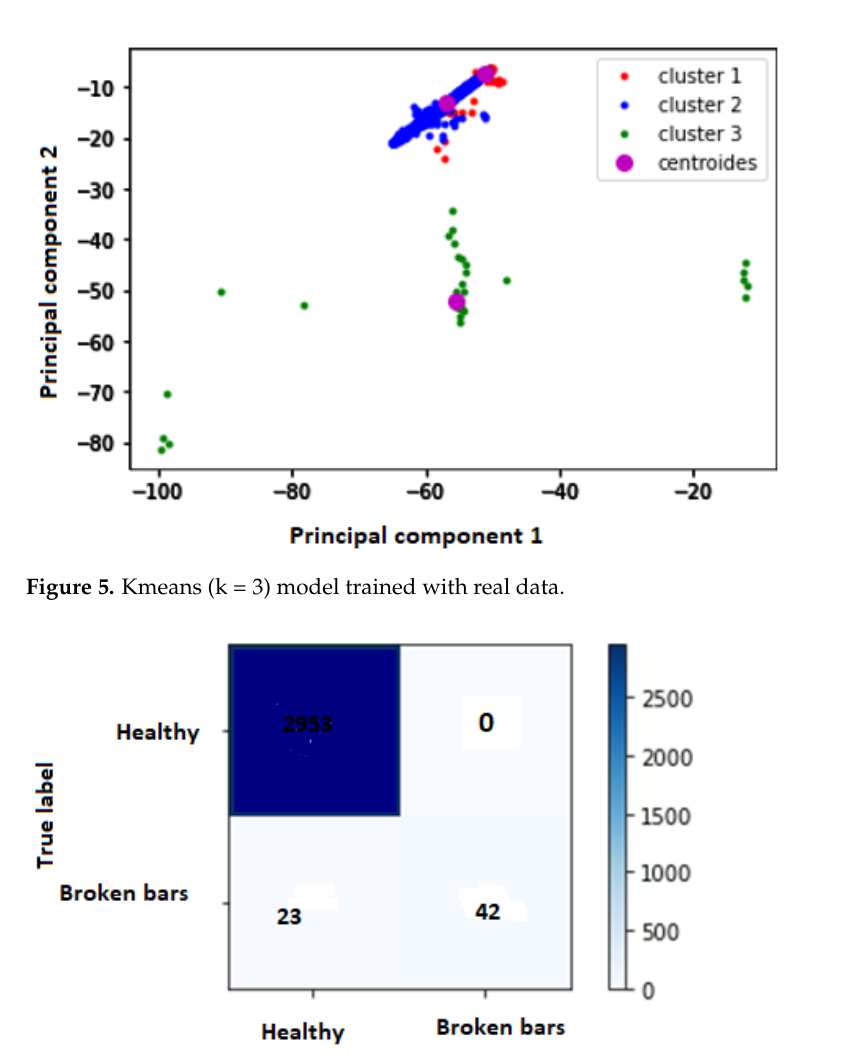
Figure 6. Confusion matrix obtained with original dataset and Kmeans .